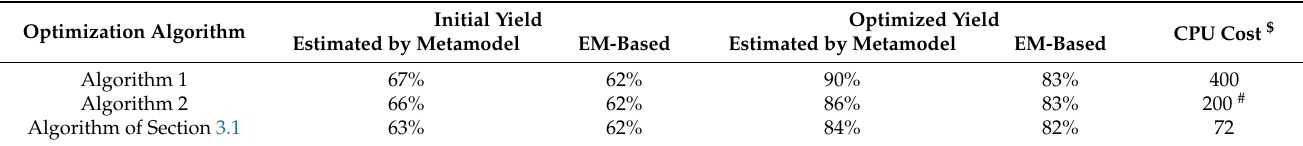
Table 3. Yield optimization of the compact coupler of Figure